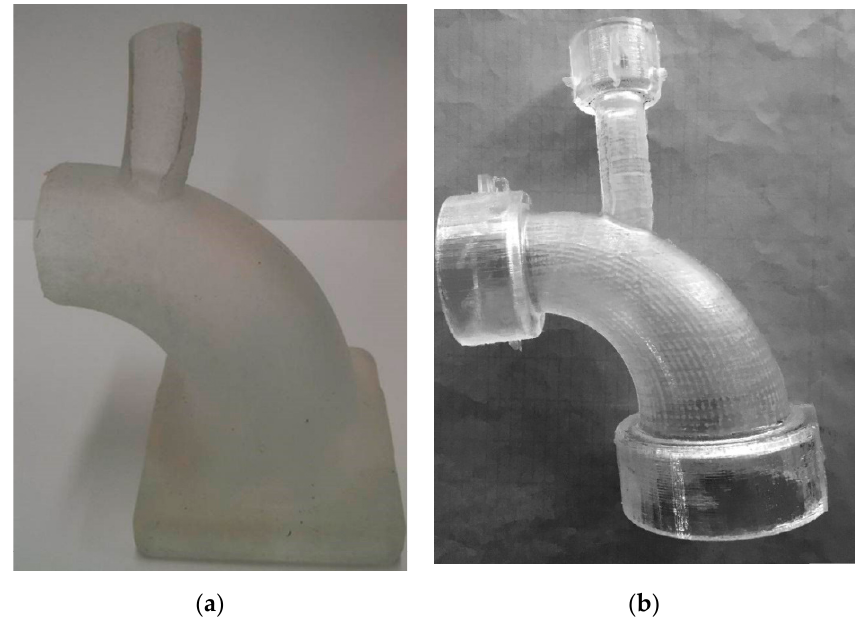
Figure 4. Extracted phantoms. The initial phantom ( a ) was cast using machined Ebalta board female mould and simple end restraints. The second phantom ( b ) was moulded with 3D printed male and female mould with more rigid end supports.